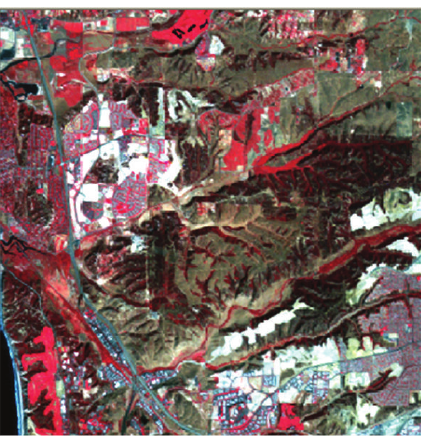
Figure 2: Original SPOT (high resolution) image.